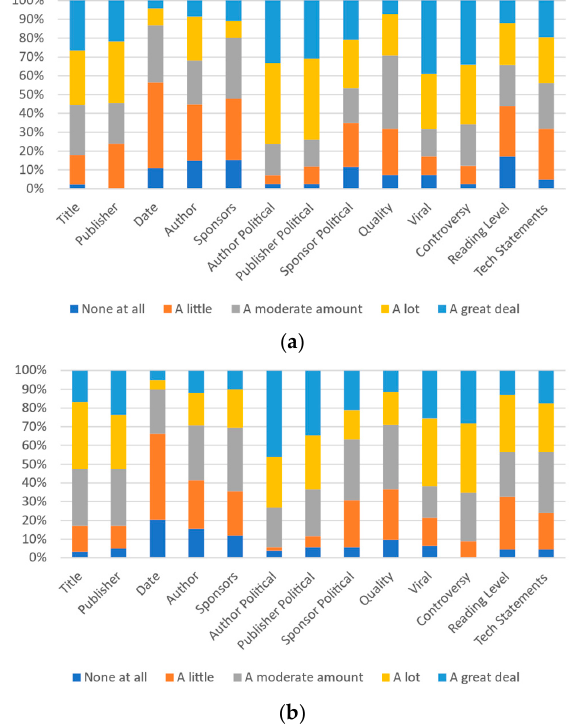
Figure 6. Participants’ responses on the magnitude of each category’s effect on most other people’s perception: ( a ) University A and ( b ) University B.